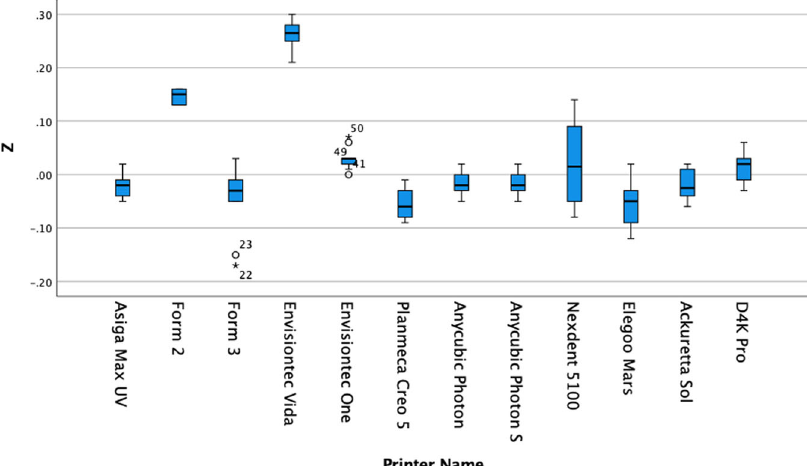
Fig. 5 Box plot of Z data set for each printer in the present study. The distribution of numerical data of the measurements of the Z dimension for each print and skewness through displaying the data quartiles and averages. The y-axis show the numerical data in terms of deviation from the actual size in microns and the x-axis labels each data set in terms of which printer it applies